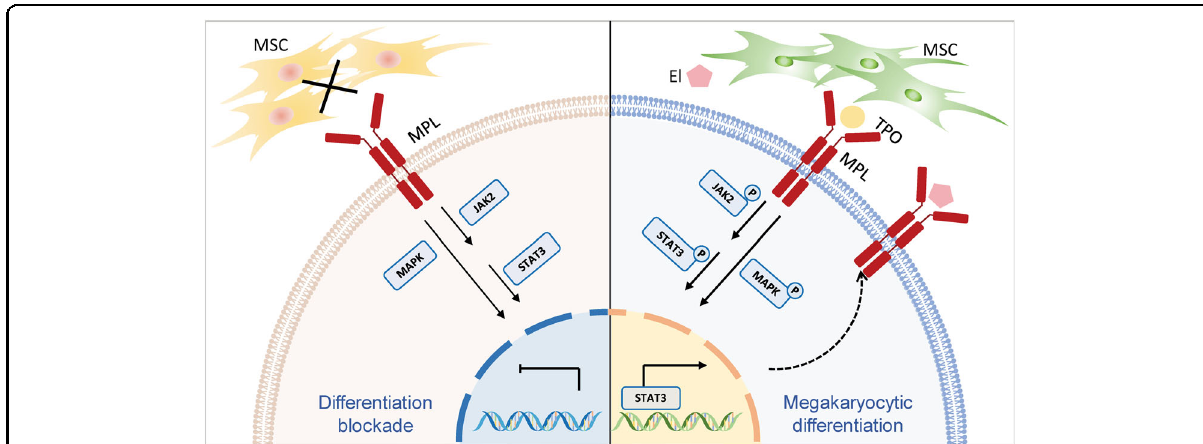
Fig. 7 Schematic depiction of MSCs/El-mediated CML cells differentiation. CML cells with impaired expression of MPL cannot respond to differentiation signals (left), whereas allogeneic MSCs promoted leukemic cell differentiation via restoring damaged MPL signaling (right). MSCs secreted TPO to activate JAK2/STAT3 and p38 MAPK pathways, which may, in turn, increased MPL expression. El promoted higher phosphorylation of both JAK2/STAT3 and p38 MAPK. Arrows indicated activation; bar-headed lines indicated inhibition. Solid line denoted data from the present study or existing literature; dotted line denoted potential connections that require further